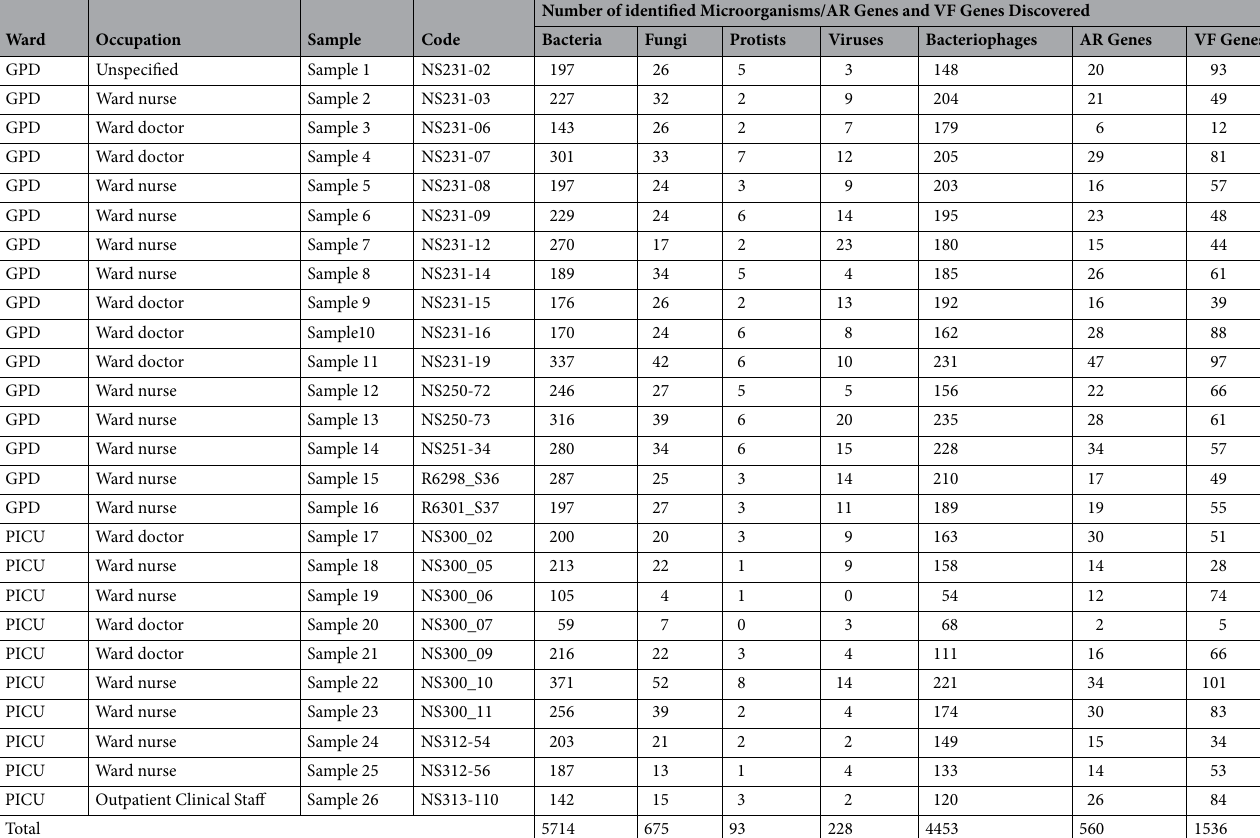
Table 1. Number of all microorganisms and genes found on each mobile phone (per ward) via shotgun- metagenomic sequencing. AR = Antibiotic resistance; VF = Virulence factors.